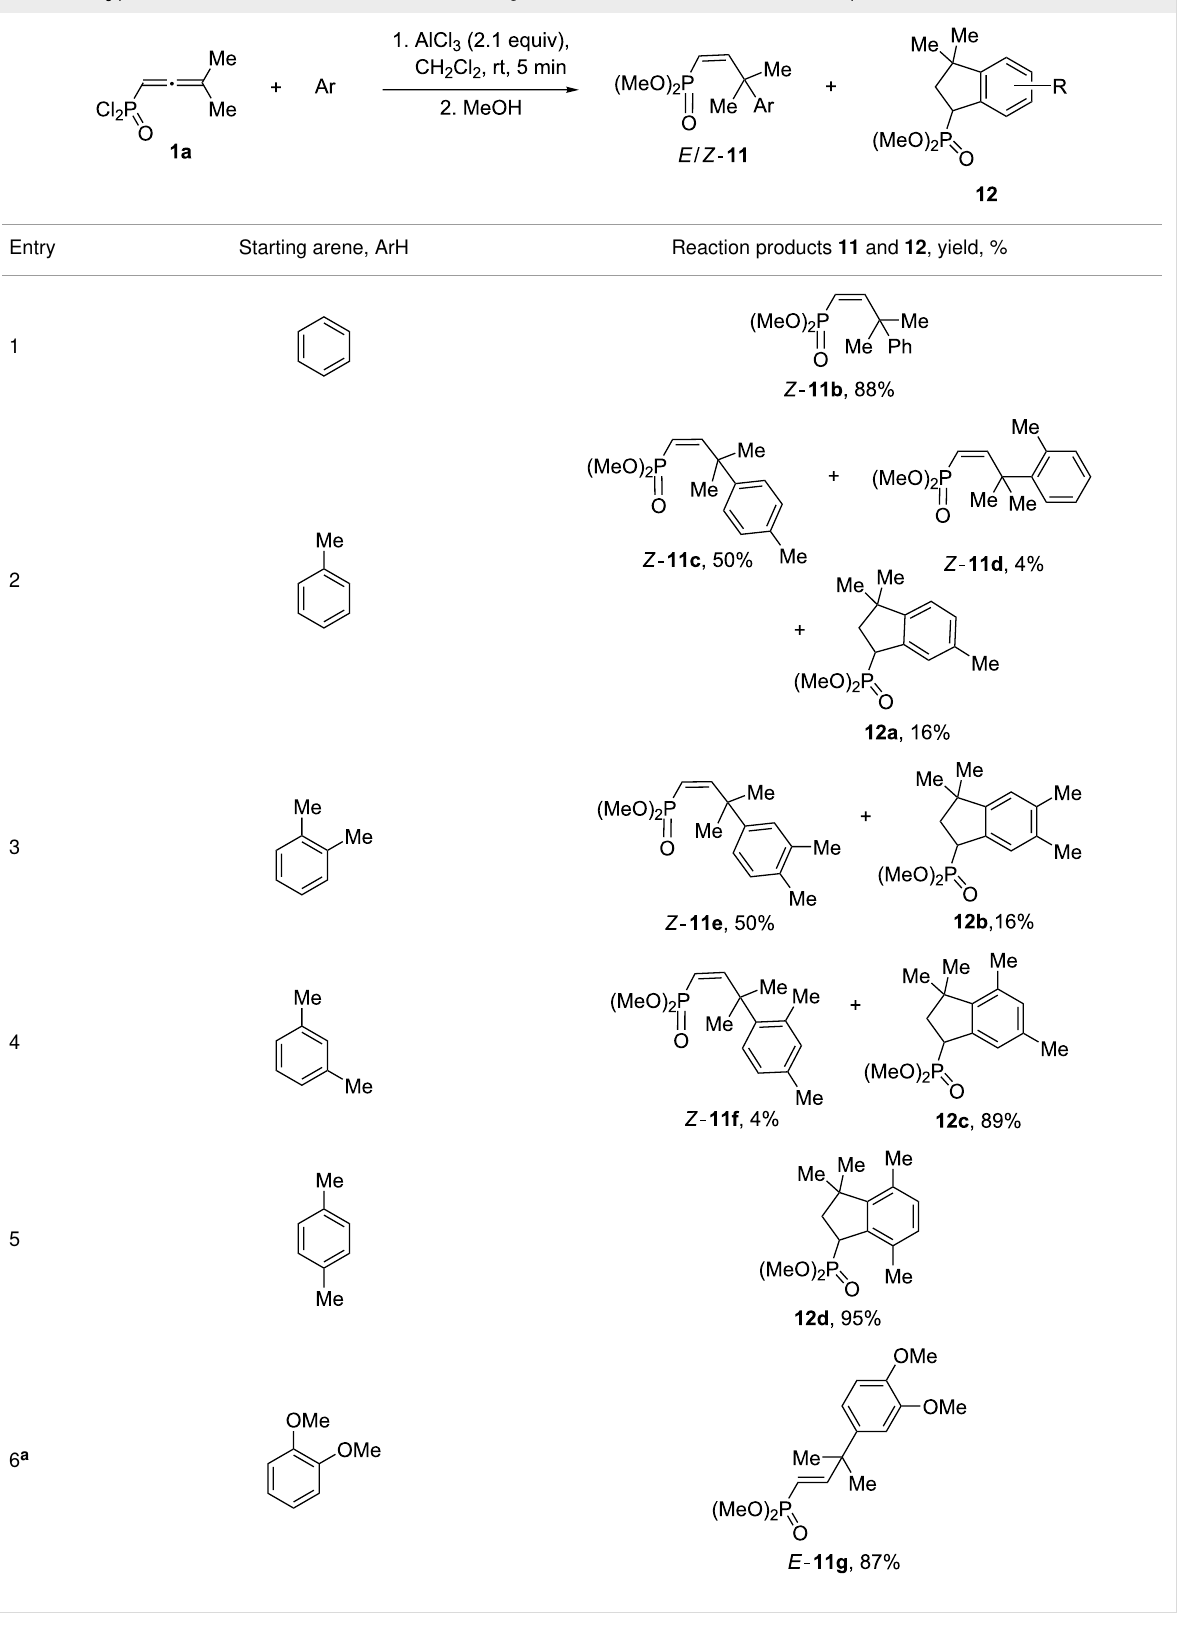
Table 3: AlCl 3 -promoted reactions of allene 1a with arenes leading to alkenes 11 and indanes 12 at room temperature for 5